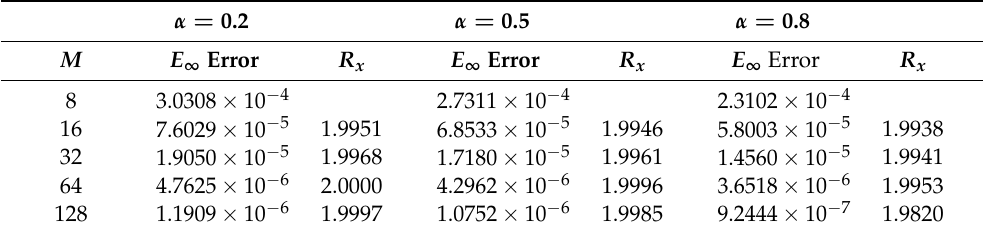
Table 9. The maximum errors and convergence rates R x for Example 3, when τ = 1/500 with different α